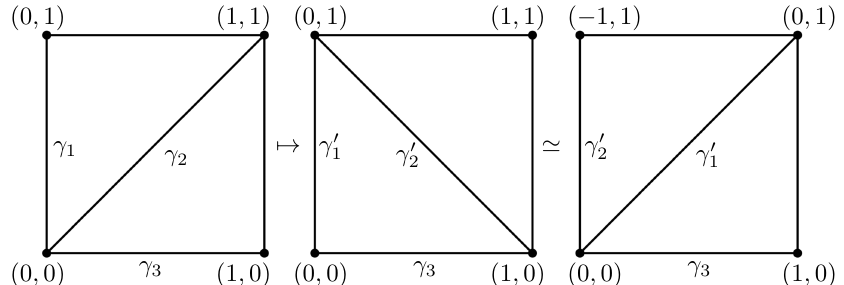
ˆ T 1 to restore the initial − 2 and then act with = γ (1) as the diagonal which is to be flipped next. 1 2